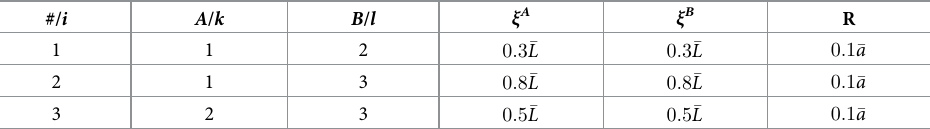
In analogy, the vertex veins are interconnected by transversal cylindrical vessels V j , j ¼ 1 ; . . . ; � j , see Table 2. The j -th vessel of this group is parameterized by Z A ated with two particular indices of vertex portal veins, and by the radius R the two links ( A , j ) 7! k and ( B , j ) 7! l . Vessel V j ¼ T ð y A Table 1. Transversal vessels U i , i = 1, 2, 3 of the central vein vasculature. The structure is generated by three vessels, see Eq (3). #/ i